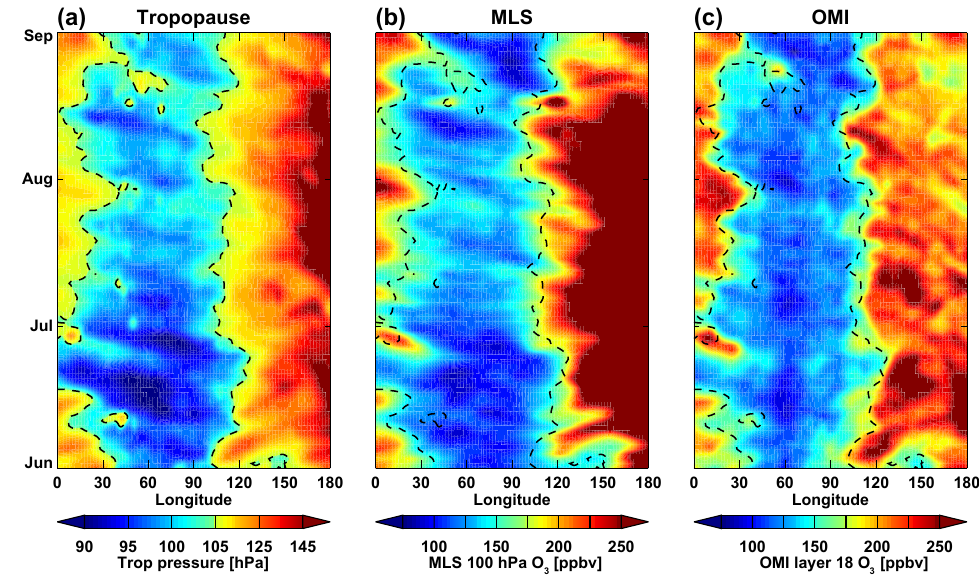
Figure 14. Longitudinal-time (Hovmöller) diagrams for (a) tropopause pressure, (b) MLS 100hPa O 3 mixing ratio, and (c) OMI layer 18 O 3 mixing ratio for the JJA season 2008. The Hovmöller diagram is constructed using the daily average over 15–35 ◦ N. MLS data have been averaged over 5 ◦ longitude bins, and OMI data have been averaged in 1 ◦ longitude bins. The 105hPa zonal average tropopause pressure is shown by the dashed line on all three fields. Gaussian smoothing is applied to all three